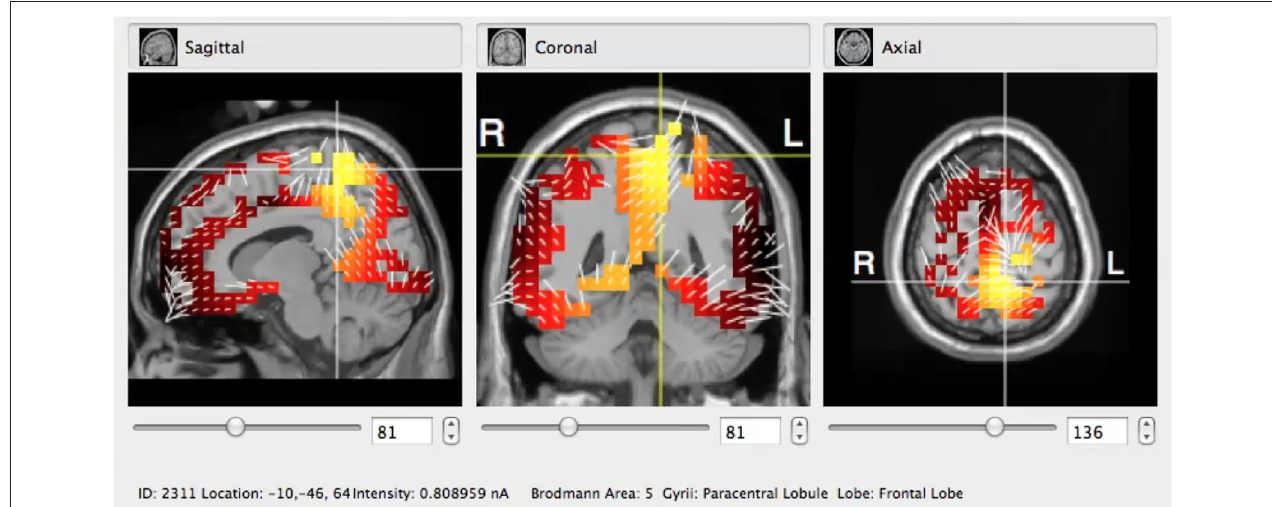
FIGURE 2 | Typical visualization of the sLORETA algorithm applied to the GeoSource pre-processed raw EEG signal in coronal, sagittal, and axial cross-sections. Here the BA5 (Paracentral Lobule, Frontal Lobe) is indicated.